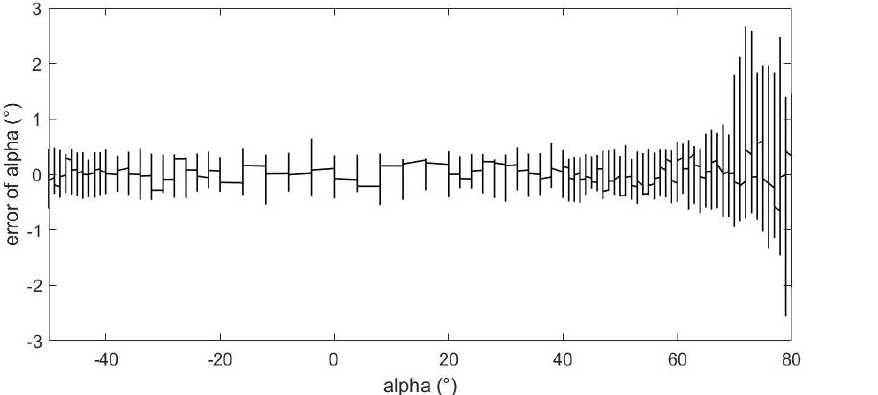
Figure 14. The relationship between angle of attack estimation error and angle of attack value.